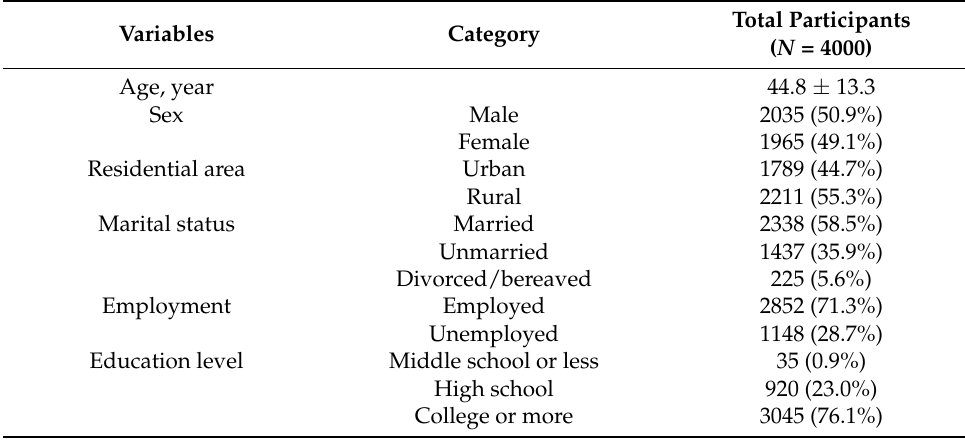
Table 1. Sociodemographic characteristics in the total